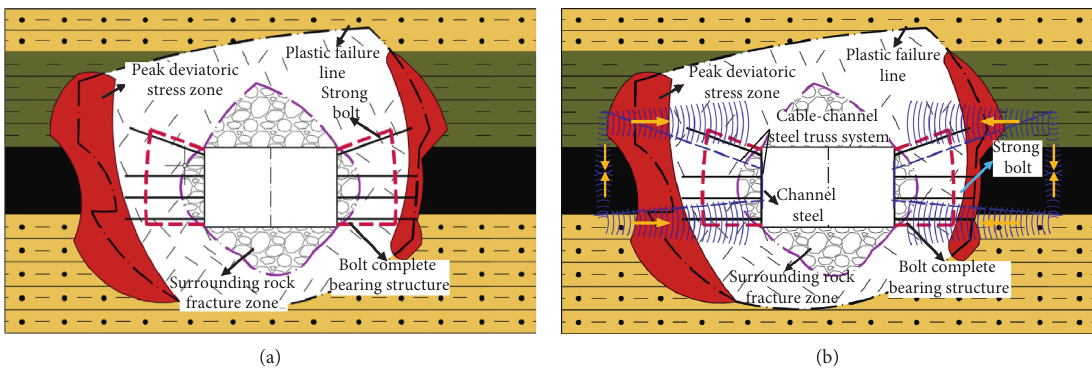
Figure 14: Principle of cable-channel steel truss system with coal side